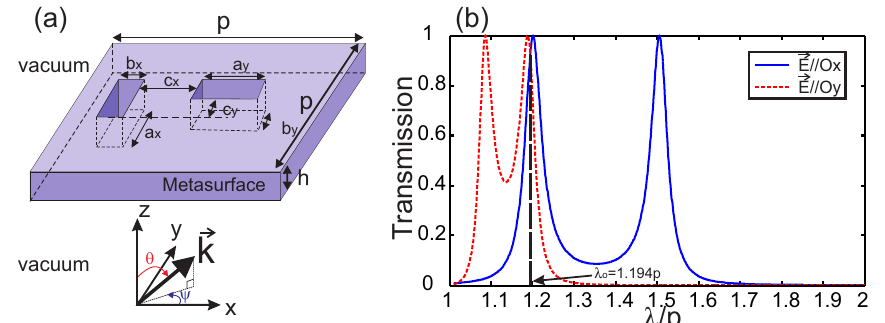
Figure 2. ( a ) Schema of a unit cell of the anisotropic metasurface. The rectangular apertures are engraved in a perfectly electric conductor layer of thickness h . The two rectangle dimensions are different in order to induce artificial anisotropy. ( b ) Typical transmission spectra for the two orthogonal polarization states along OX and OY when θ m = 0 o in the case of an incident plane wave. Second, a basis change from ( x , y ) → ( s , p ) → ( x , y ) is necessary to determine the